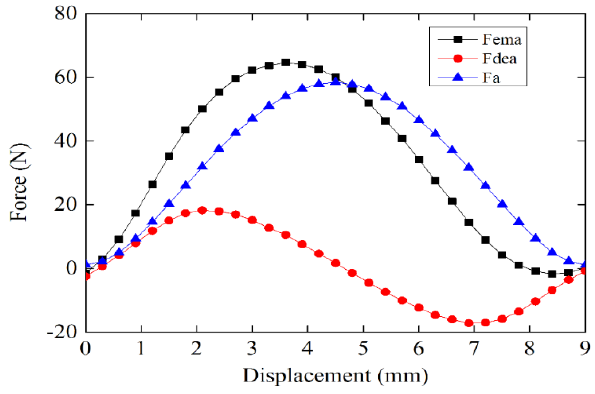
Figure 8. Force versus displacement of STTF ‐ PMLSM.